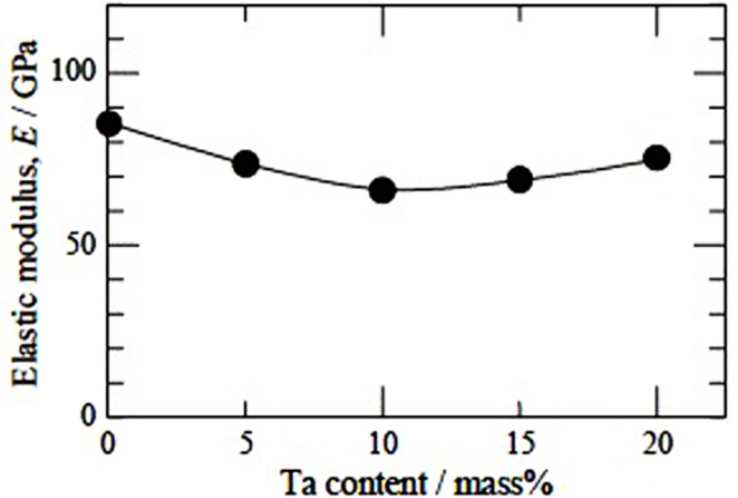
Figure 6. Effect of Ta addition on elastic modulus of Ti-30Nb-XTa-5Zr alloy [89]. Reprinted with permission from [89]. Copyright 2005 Elsevier.